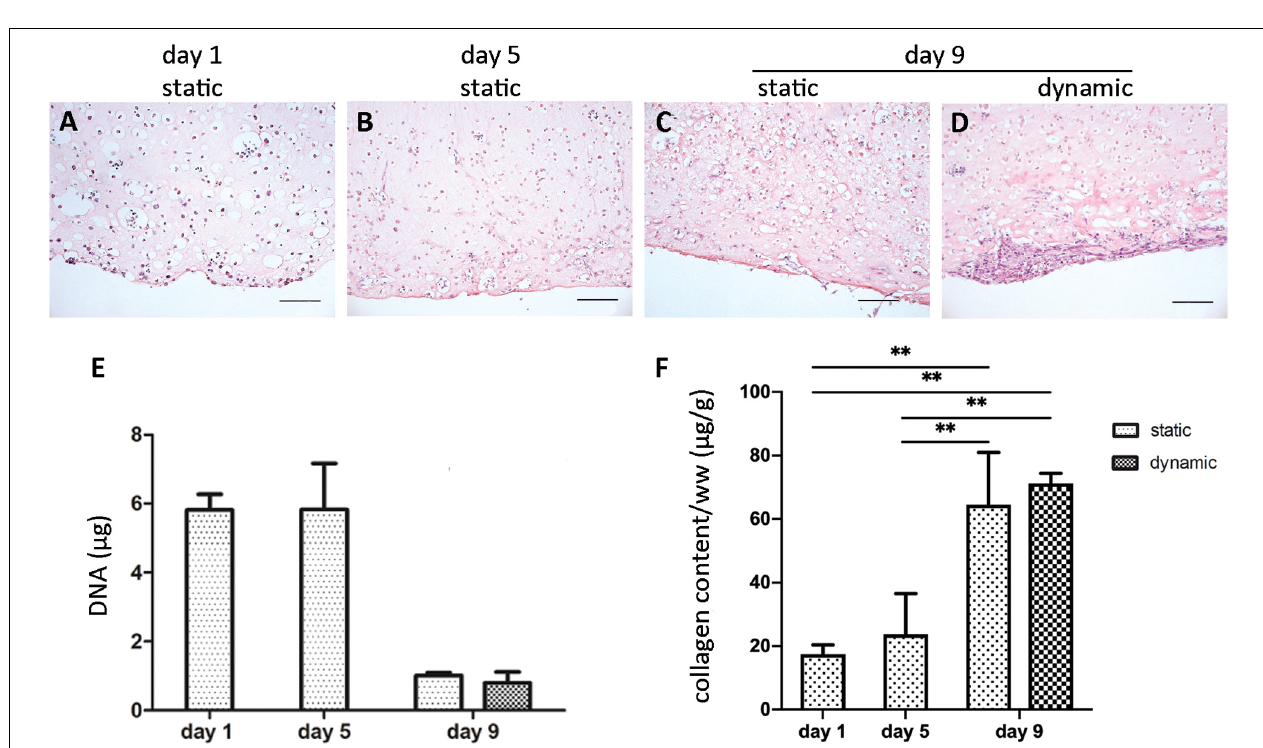
FIGURE 3 | ECT cell distribution and DNA and collagen content. Representative H&E staining showing cell distribution within an explanatory ECT at the beginning (day 1) of the culture (A) , at day 5 (B) , and following either static (C) or dynamic (D) culture at day 9. Scale bar = 100 µ m. Graphs showing the DNA amount (E) and the collagen content normalized by ww (F) for ECTs at the beginning (day 1) of the culture, at day 5, and following either static or dynamic culture (day 9). For all groups n = 3, ∗∗ p ≤ 0.01.